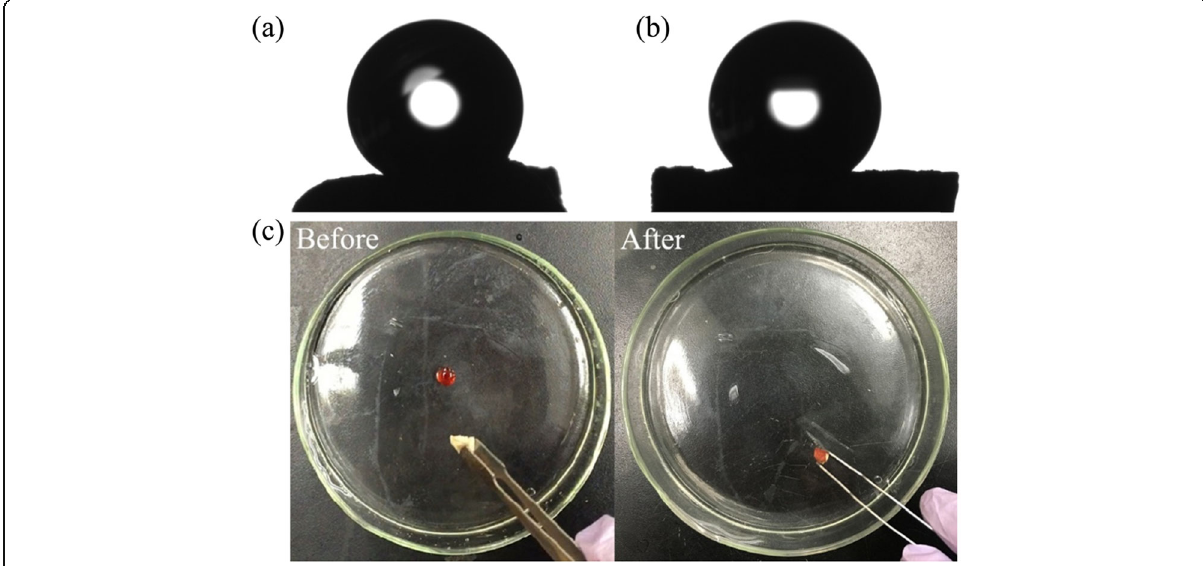
Fig. 4 Water contact angles of the MTMS vapor treated LC aerogel: a on an external surface, and b on a freshly fractured surface. c Pump oil absorption process by the MTMS vapor treated LC aerogel